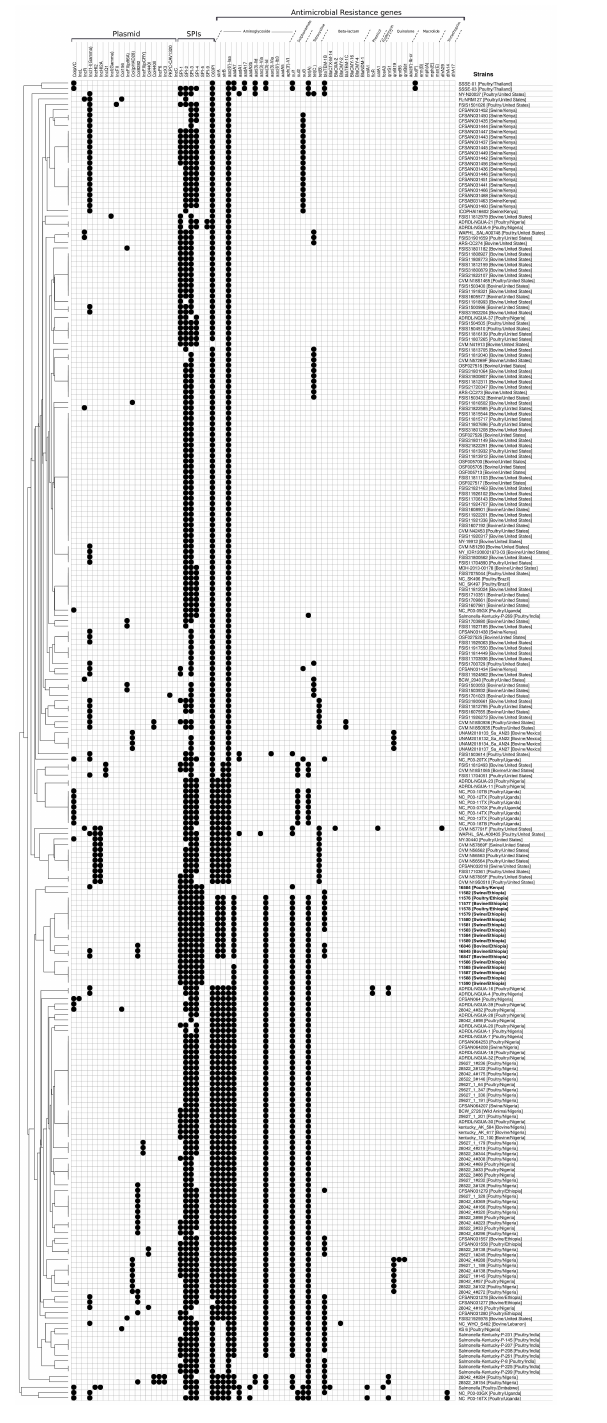
FIGURE 1 | Antimicrobial resistance pro fi le, pathogenicity islands and plasmid detected in both 19 Salmonella Kentucky isolates from the African Horn region and 229 publicly available Salmonella Kentucky genomes. The isolates were clustering according to the presence/absence of pathogenicity islands and plasmid, and antimicrobial resistance determinants as